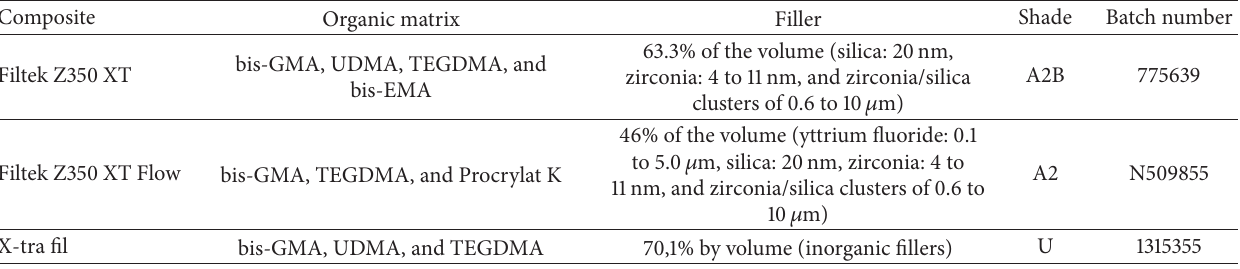
Table 1: Information about the composites employed according to the manufacturer.